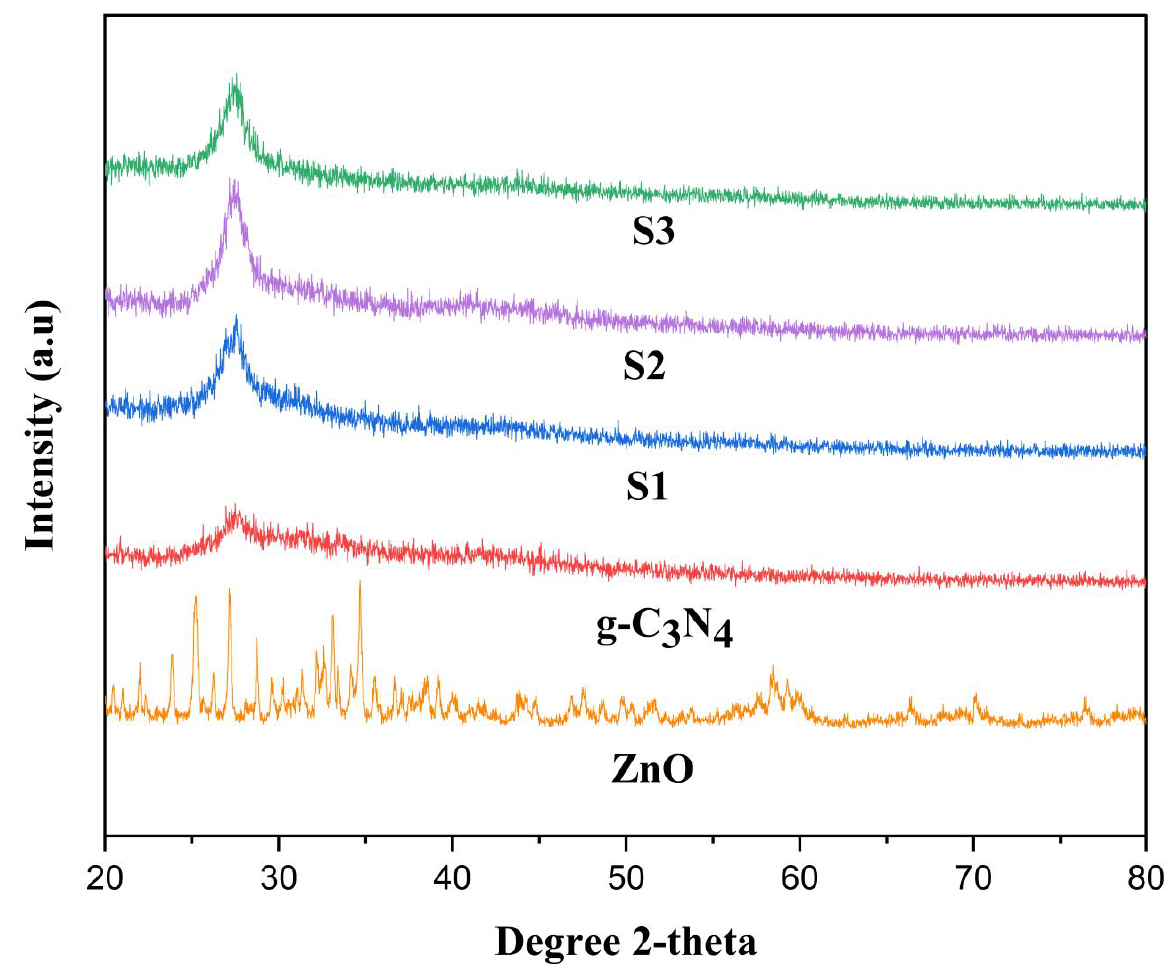
Figure 1. XRD of ZnO, g-C 3 N 4 , S1, S2, and S3 POA/g-C 3 N 4 /ZnO